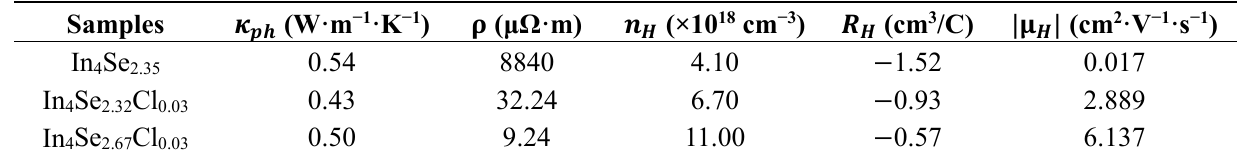
Table 4. Estimated high-temperature lattice thermal conductivity (cid:2018) electrical resistivity ρ , carrier density (cid:1866) indicated crystalline